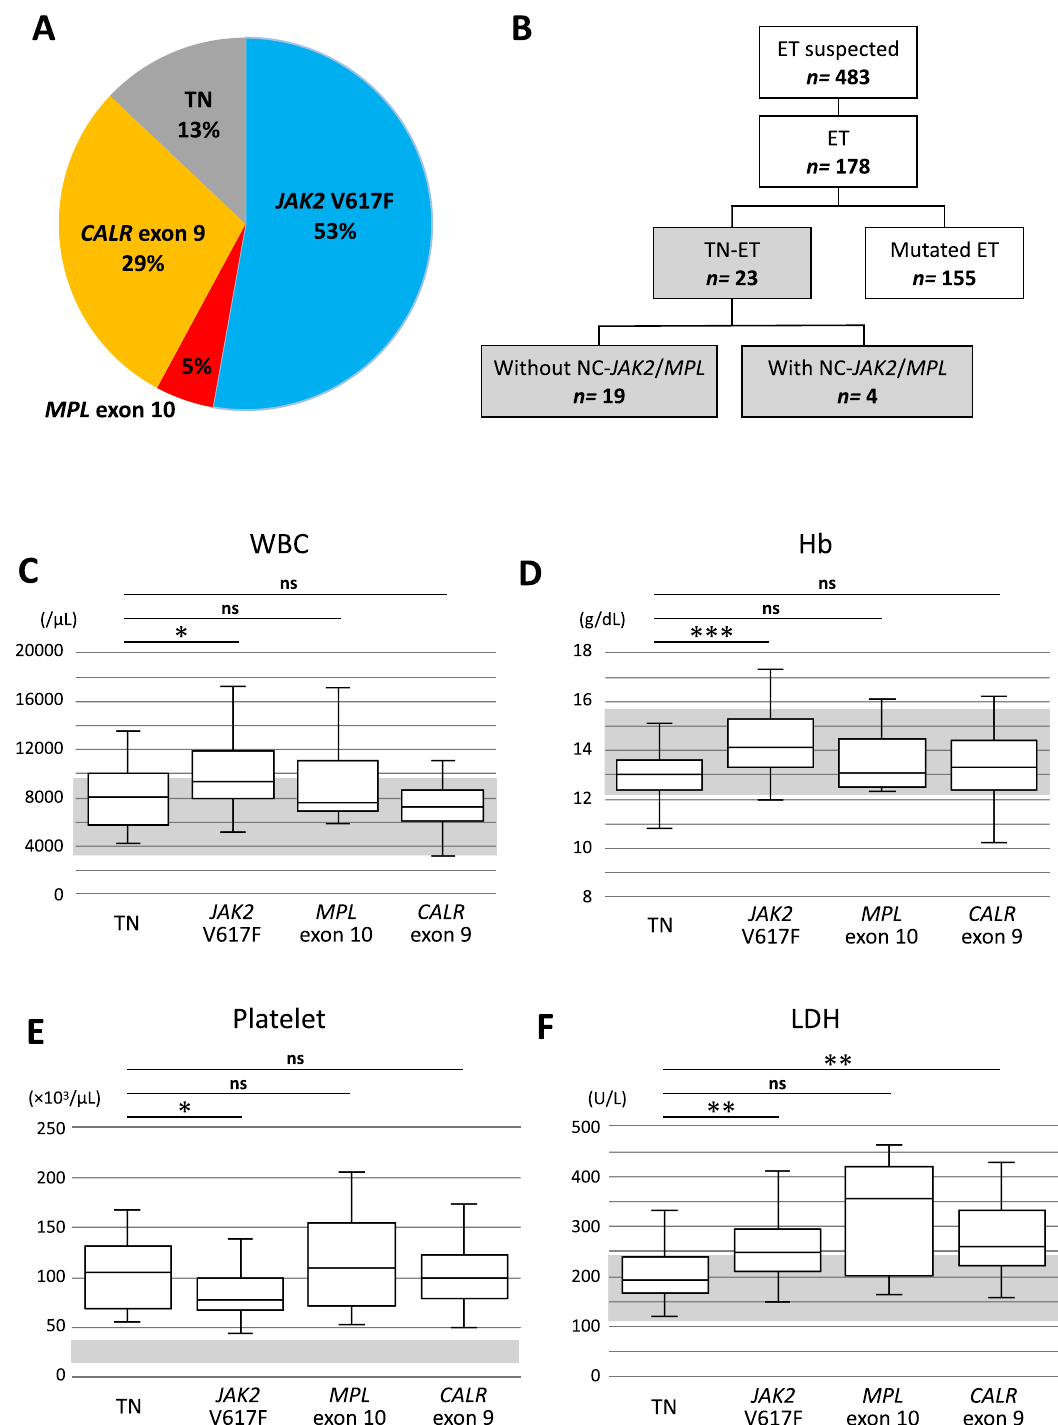
Figure 1. Comparison of clinical parameters between the TN-ET patients and mutated ET patients. ( A ) Frequencies of driver mutations in the ET patients in our cohort. ( B ) A diagram presenting the mutation profiles of the TN-ET patients. NC- JAK2 / MPL : noncanonical JAK2 and MPL mutation. The WBC count ( C ), Hb value ( D ), platelet count ( E ), and LDH level ( F ) for the patients classified based on driver mutation status are shown. Gray highlight shows normal range. * < 0.05, ** < 0.01, *** < 0.001, ns: not